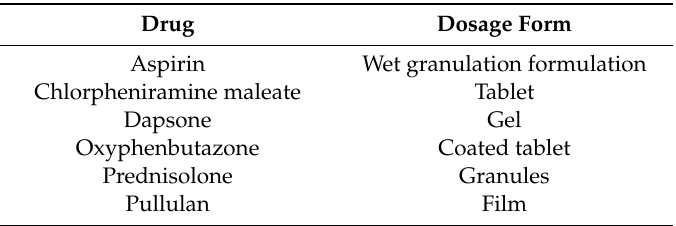
Table 6. Chitosan-based drug delivery